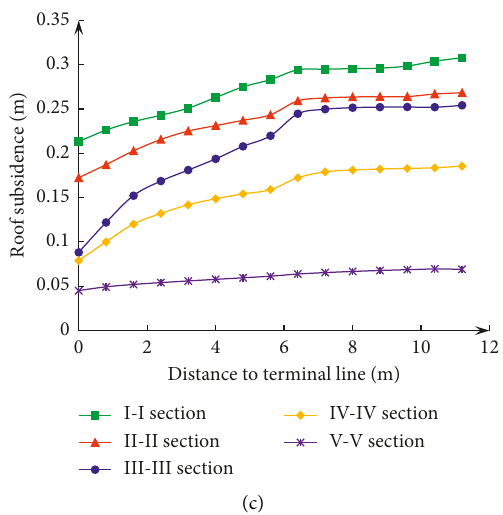
Figure 23: Roof subsidence curves of Stage III. (a) Scheme 1. (b) Scheme 2. (c) Scheme 3.